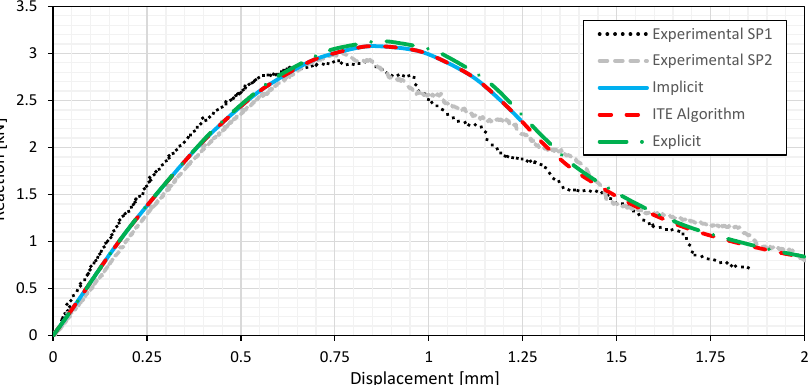
Figure 6. Vertical force vs. displacement in the load supports for the CT test.